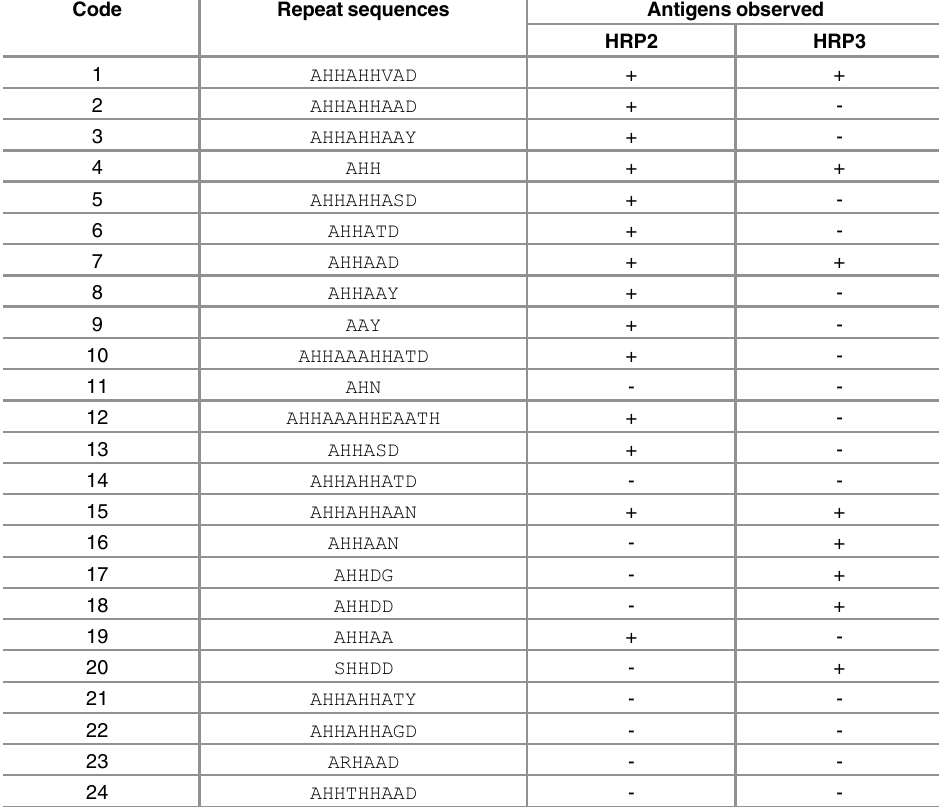
Table 4. Amino acids repeats along with codes observed in Plasmodium falciparum histidine rich pro- tein 2 and 3. Code Repeat sequences Antigens